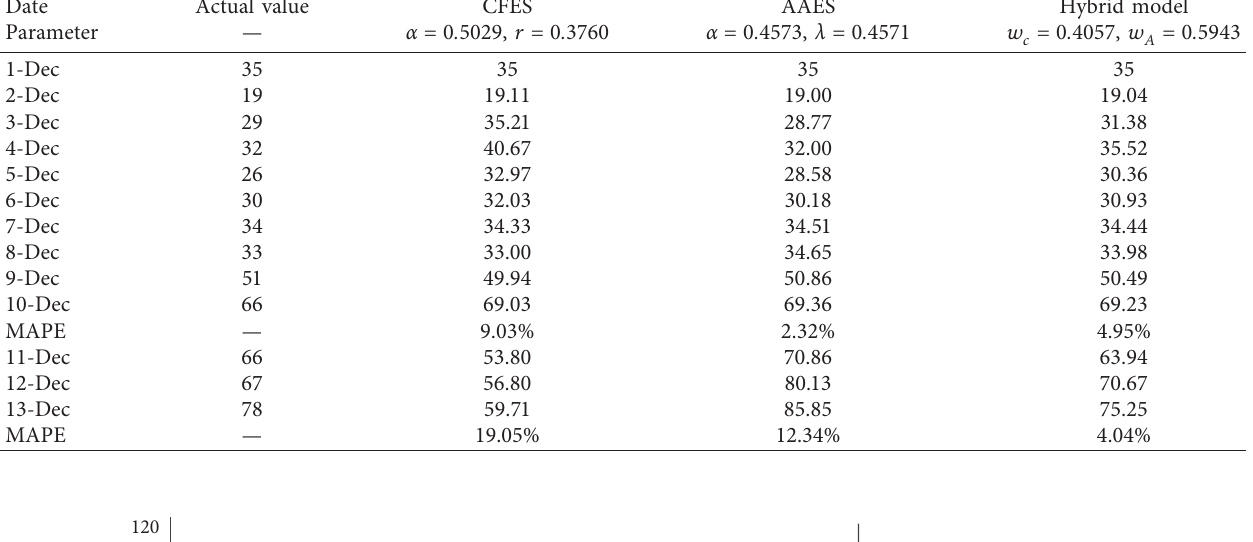
Table 6: The forecasting results of PM